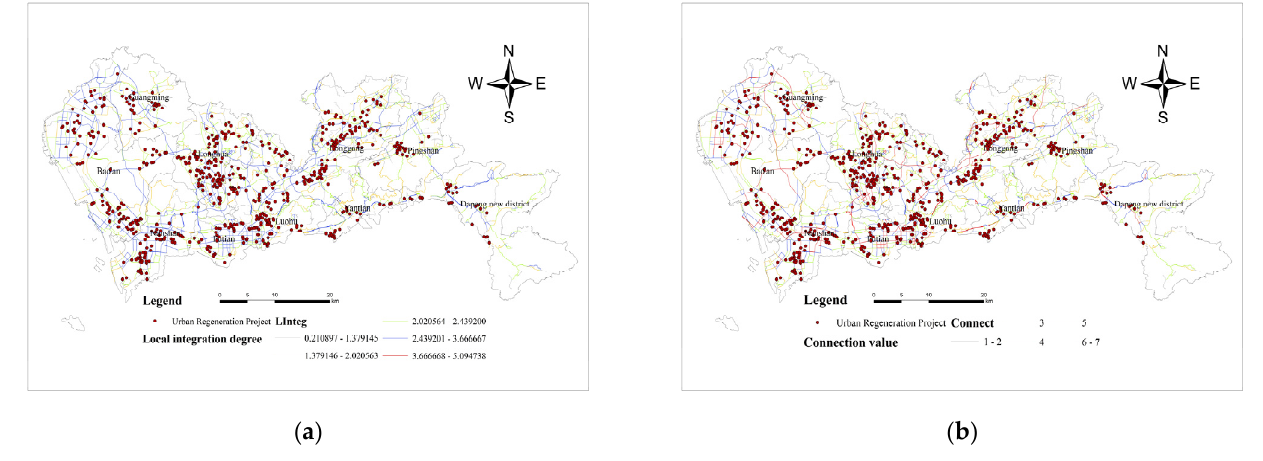
Figure 7. UR and Spatial Syntax Map: ( a ) local integration and ( b ) connection.